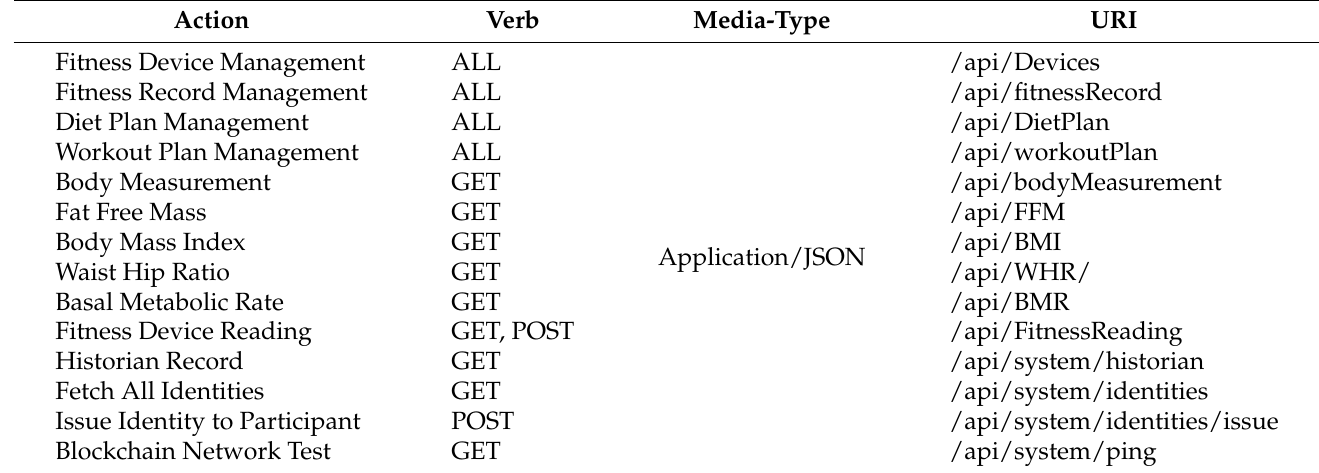
Table 8. RESTFul application programming interface (API) for proposed fitness blockchain platform.